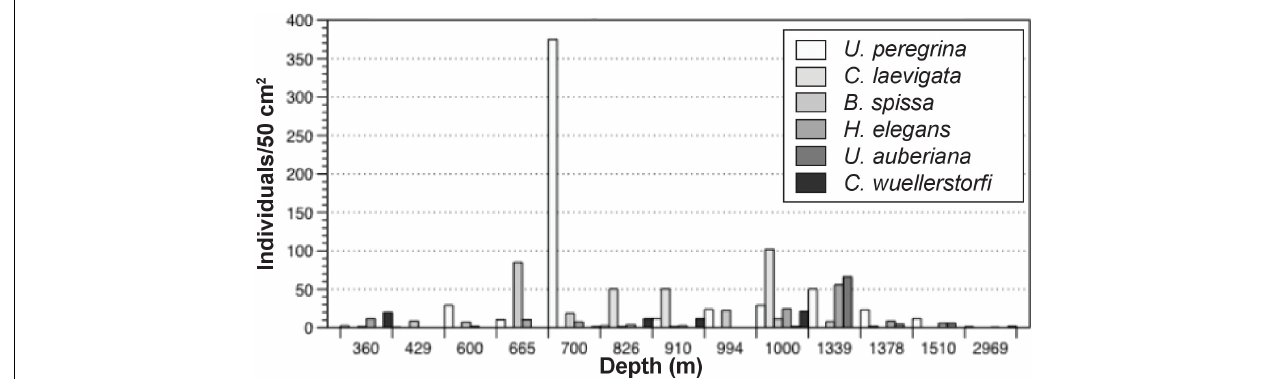
FIGURE 4 | Distribution of the six most abundant >150 micron taxa along the transect.